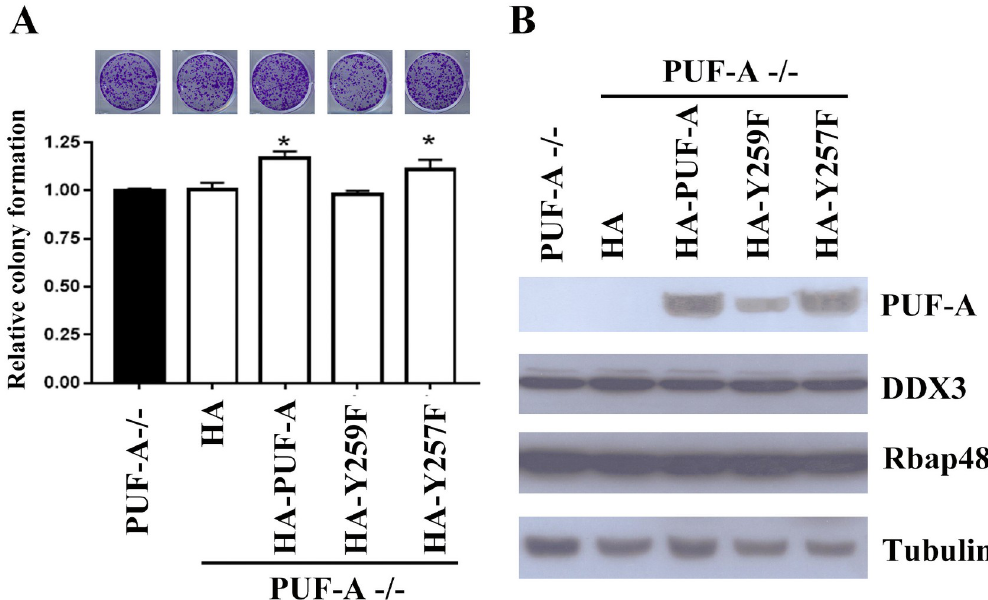
Fig 5. Phosphorylation of PUF-A on Y259 was essential for cell proliferation. (A) HA-PUF-A, HA-PUF-A Y259F (HA-Y259F) and HA-PUF-A Y257F (HA-Y257F) were transfected into PUF-A ablated HeLa cells. 2x10 3 cells were plated on 6-well dishes and grown for 12 days. Cells were stained with crystal violet and representative images are shown above. Colonies larger than 0.1 mm in diameter were scored. Quantitative results are shown and each bar represents the mean ± SD of three independent experiments. � P < 0.05. (A) Cell extracts were immunoblotted with the indicated antibodies.